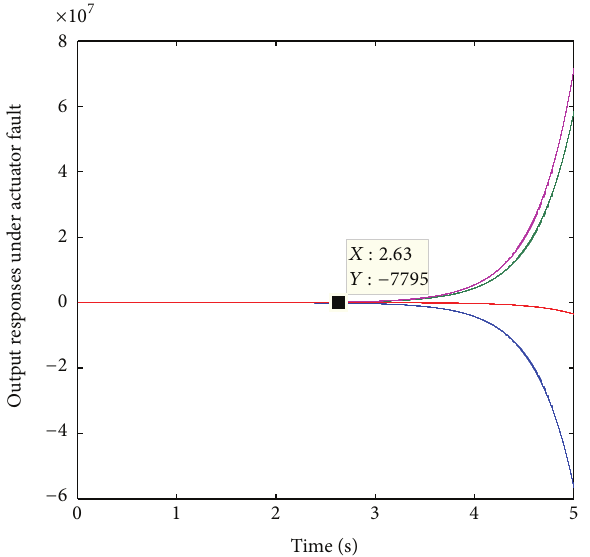
Figure 3: Output of the system with data packet dropout and actu- ator